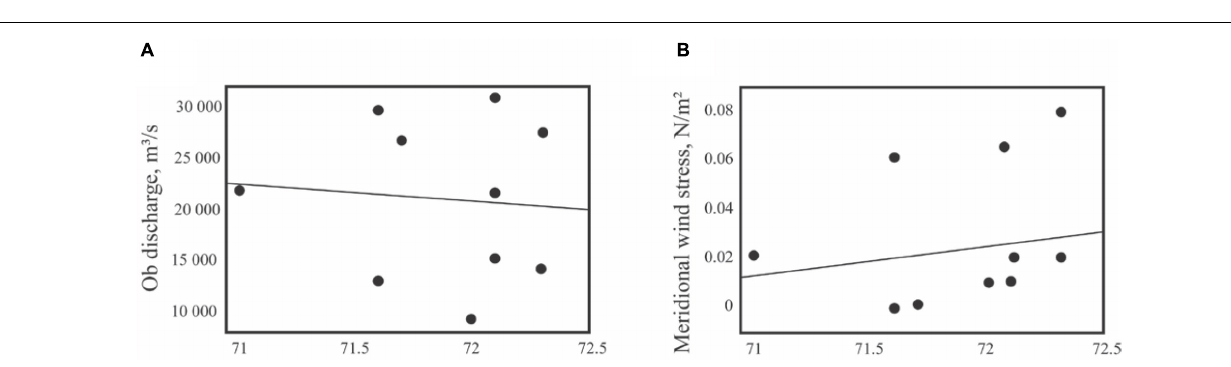
of Ob, which is visible at satellite altimetry data ( Figure 8